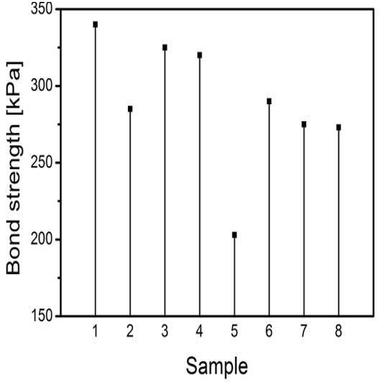
Results of binding properties examination conducted with tensile machine.